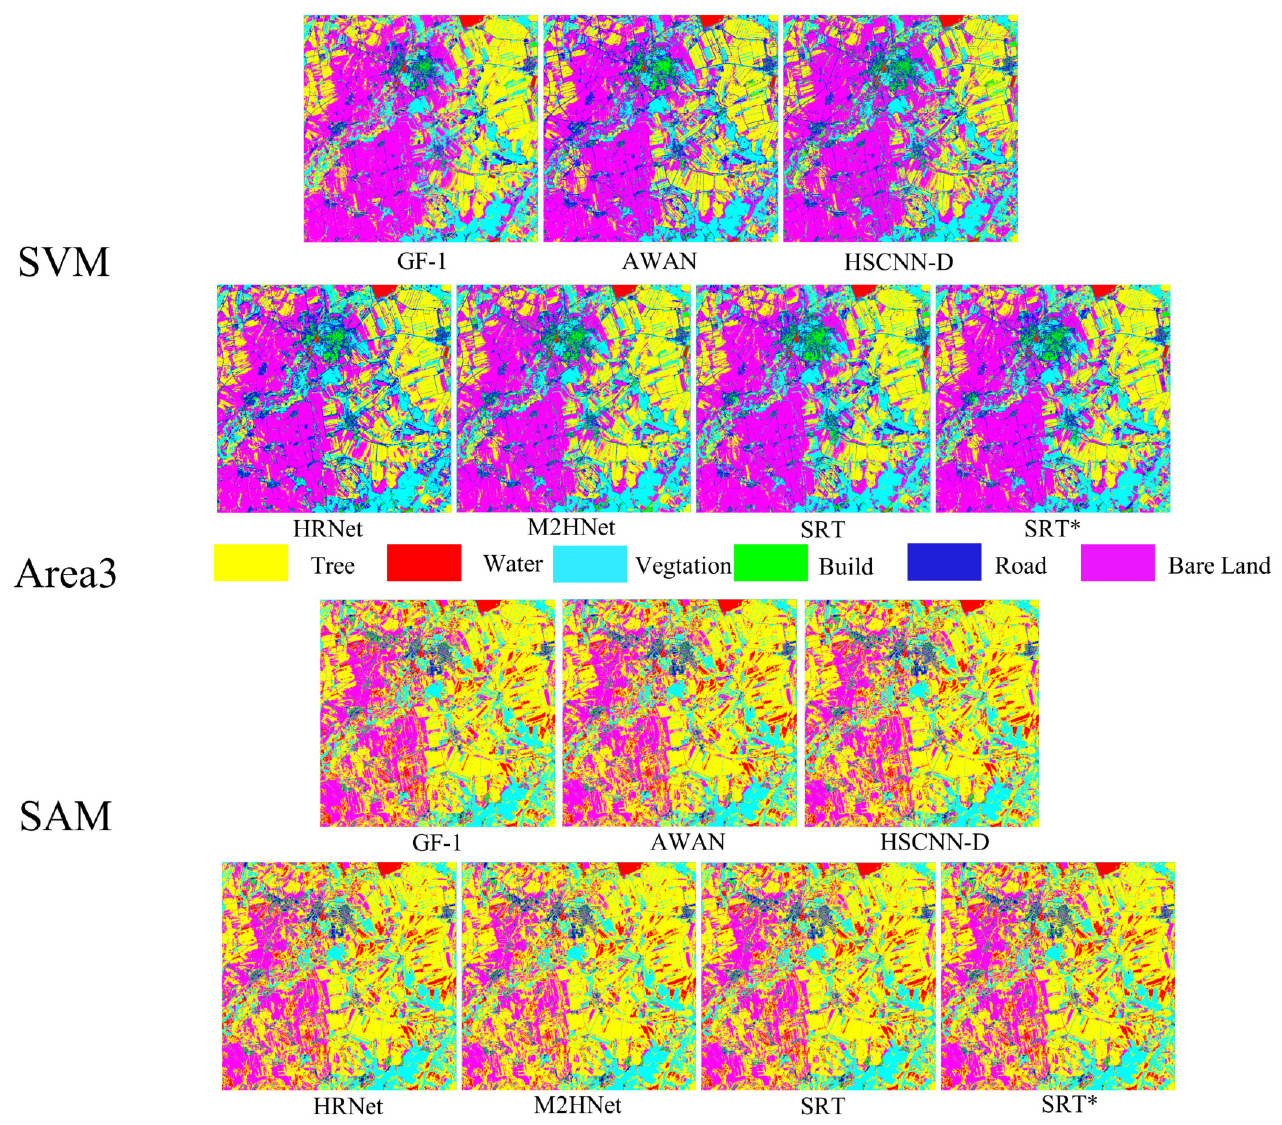
Figure 10. Result of SVM classification on